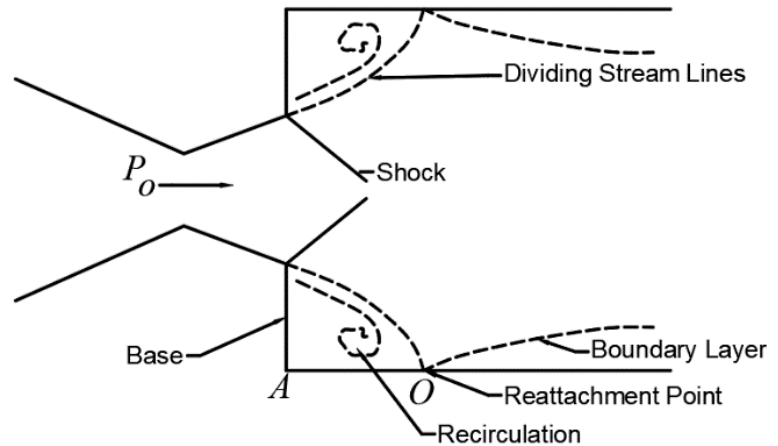
Figure 2. Schematic diagram of over-expanded flow field.